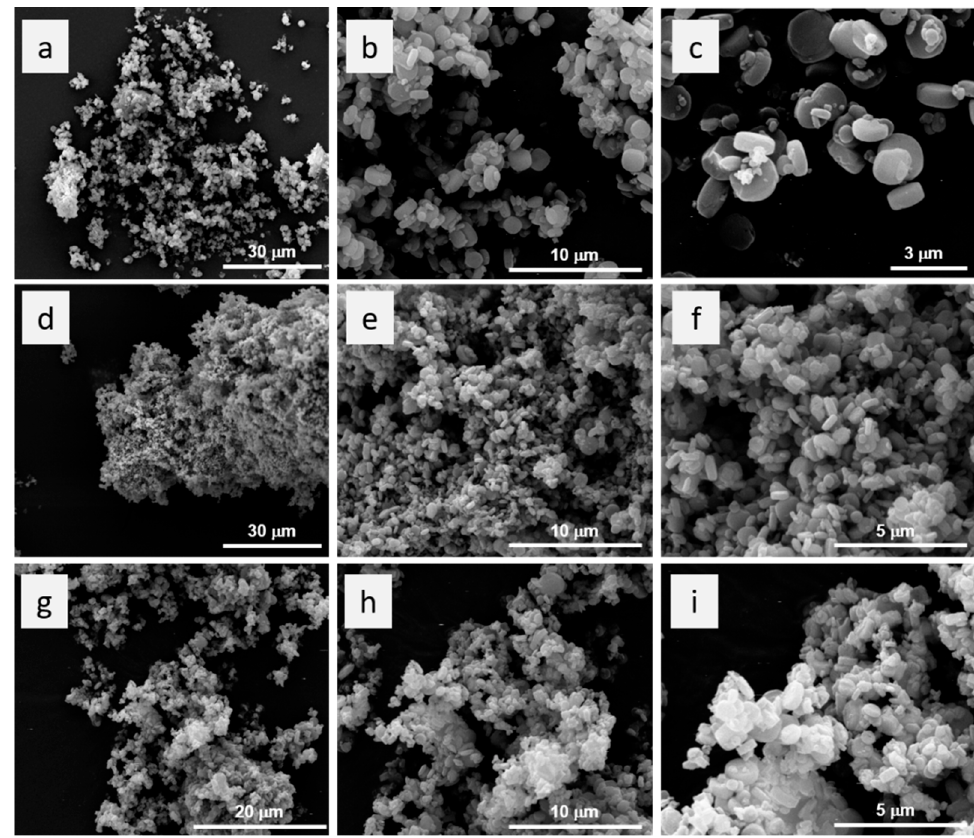
Figure 1. SEM images of MIL125-(Ti): ( a – c ), MT-500 ( d – f ) and MT-600 ( g – i ) at different magnifications.